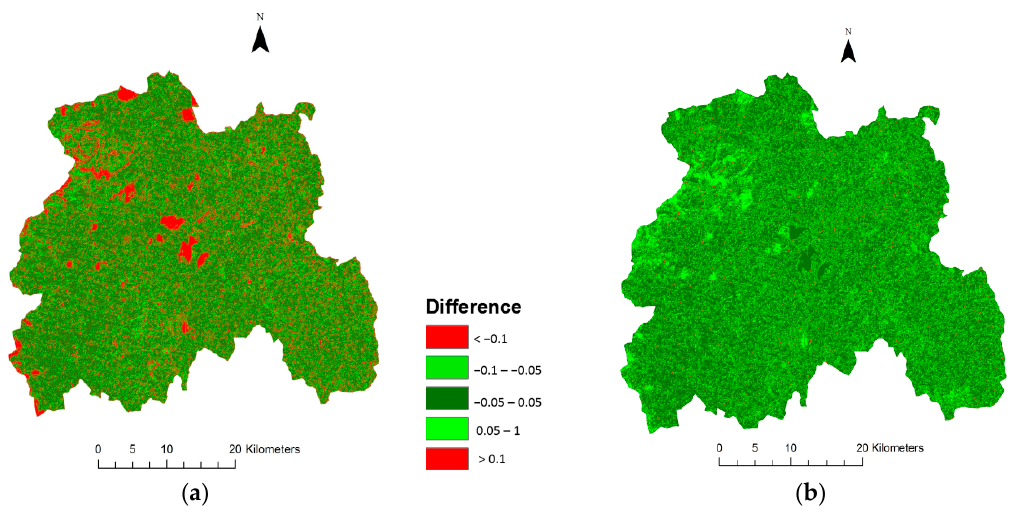
Figure 8. Difference between METRIC and modelled ET r F (12 July 2013): ( a ) initial case; and ( b ) after masking IW class.